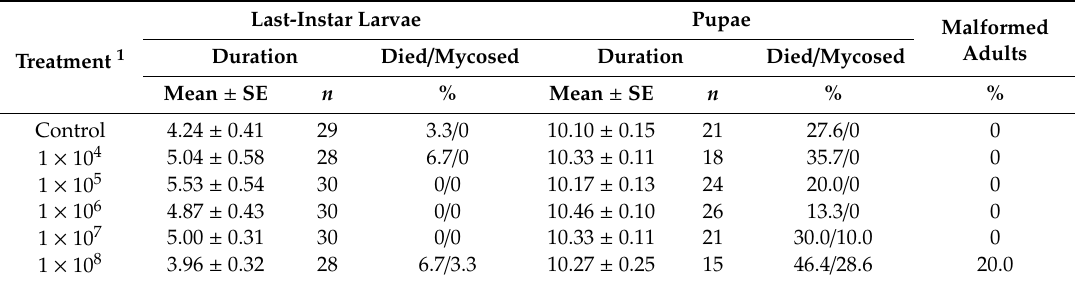
Table 1. The e ff ects of Isaria fumosorosea on the development of Cydalima perspectalis .